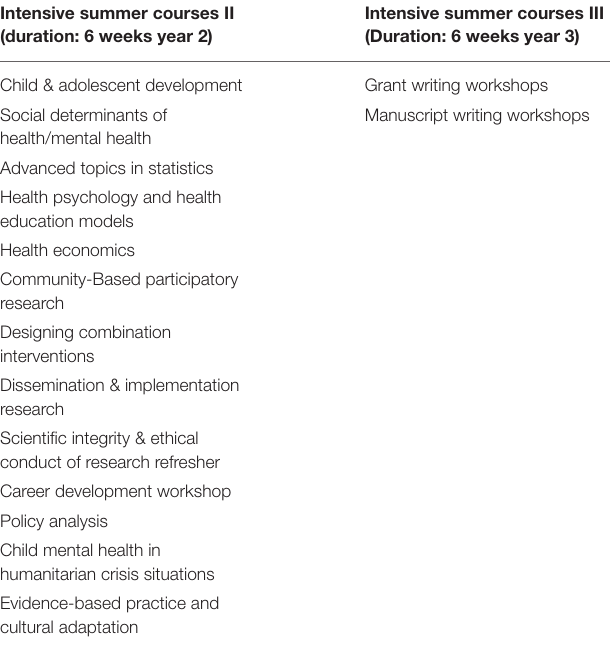
TABLE 2 | Overview of the intensive summer training courses in years 2 and 3.